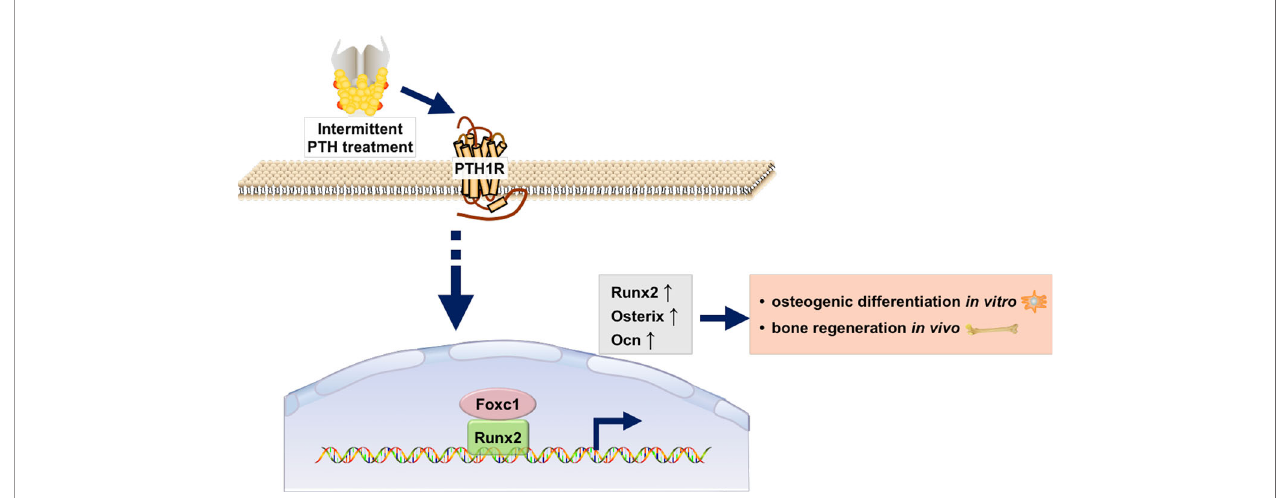
FIGURE 6 | Schematic illustration of the regulation of Runx2 by Foxc1 in response of intermittent